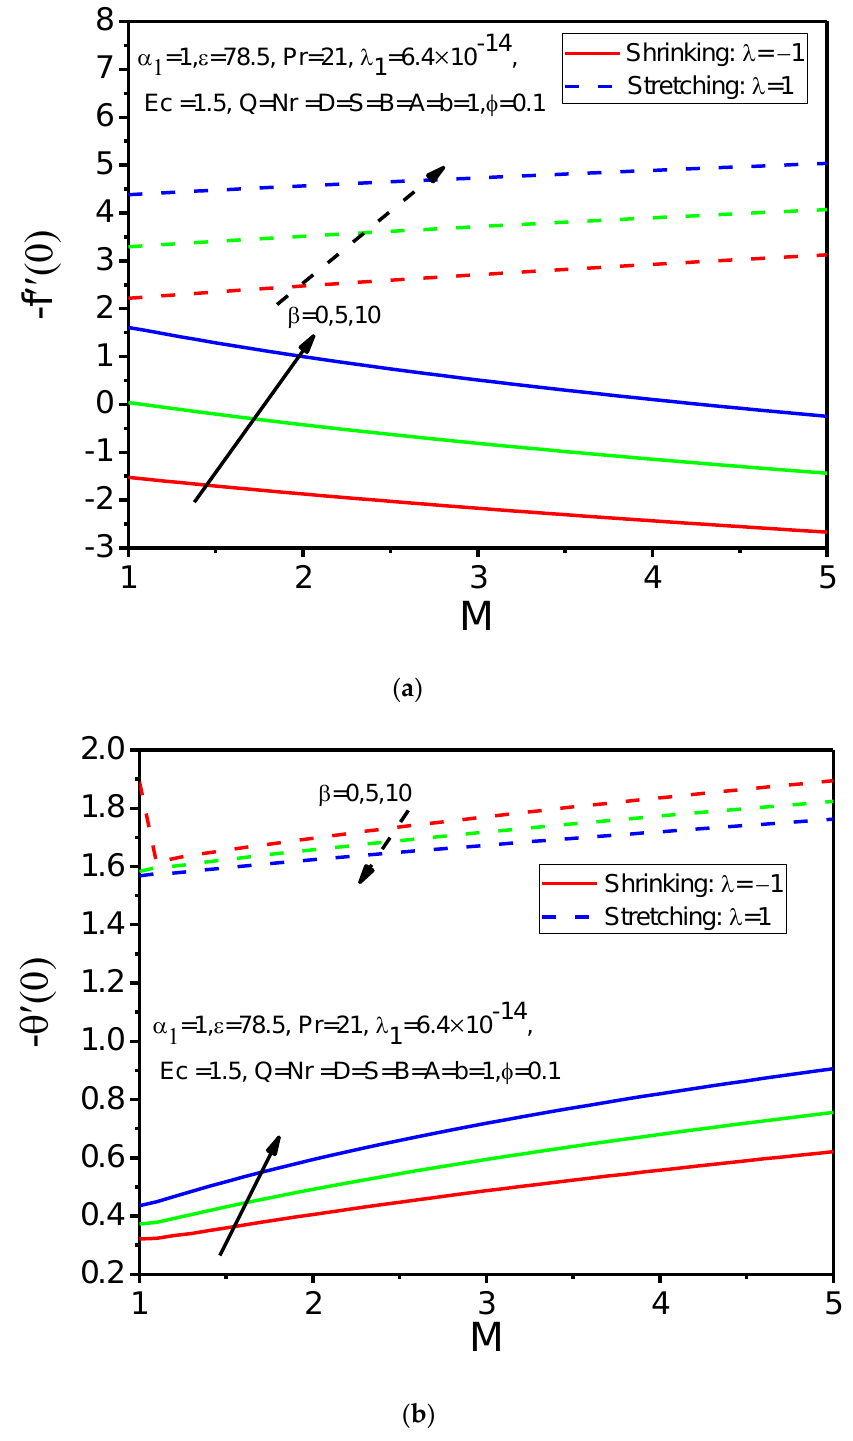
Figure 13. Influence of β against M on ( a ) Skin friction coefficient, ( b ) Rate of heat